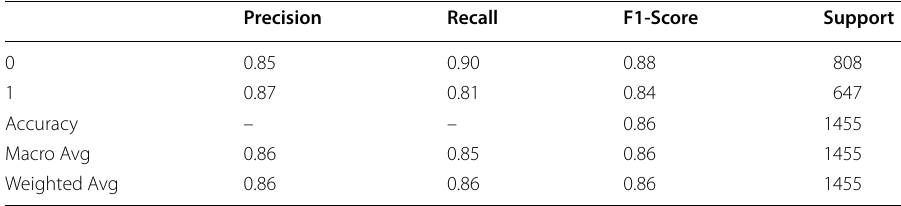
Table 6 Experiment 1 with SemEval dataset